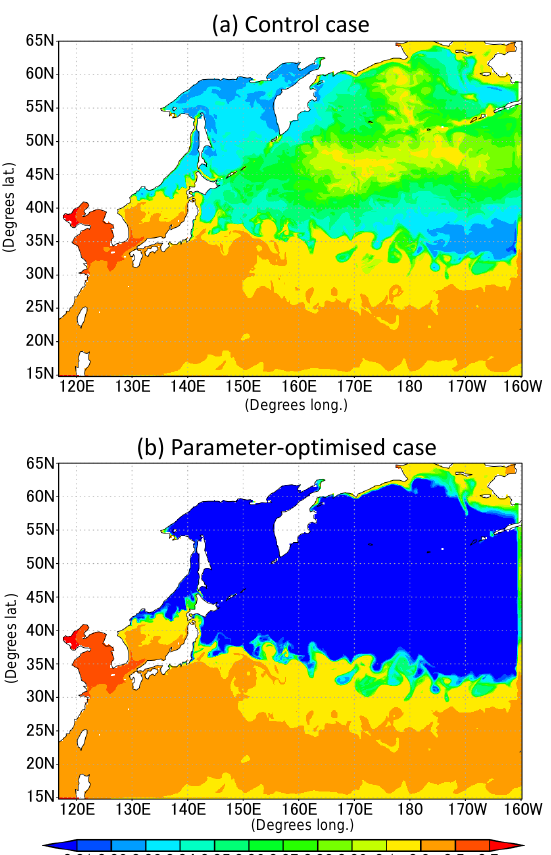
Figure 12. Horizontal distribution of dissolved iron in the surface seawater layer for July 1998; (a) control case and (b) parameter- optimized